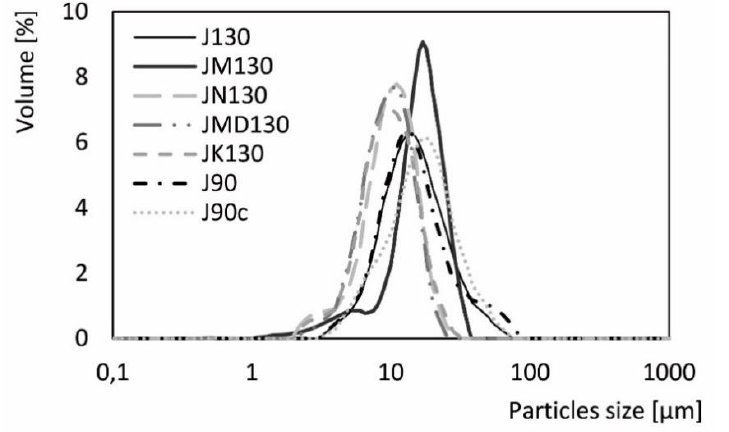
Figure 2. Particle size distribution of cloudy beetroot juice powders (abbreviations of variants explained in Table 1).